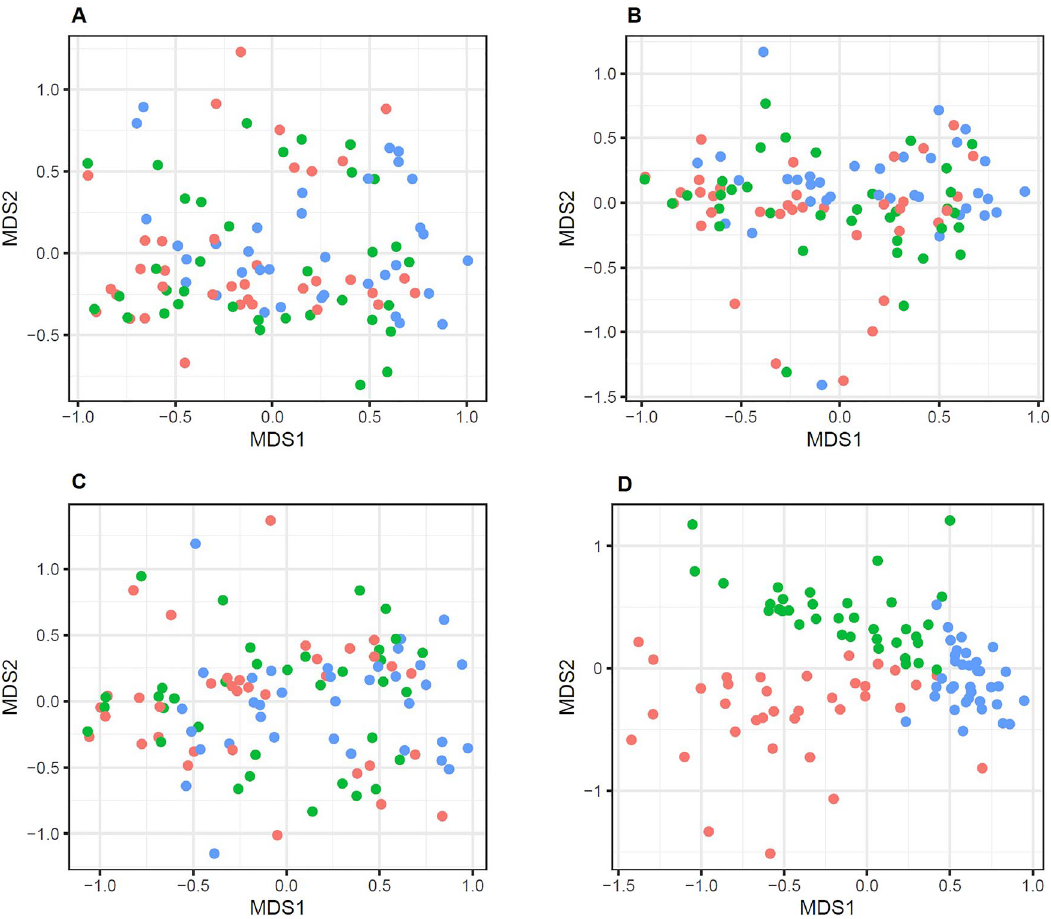
Figure 3. Bacterial community structures of urine depending on the way of sampling (red, first-catch urine; green, mid-stream urine; blue, catheterised urine), under 4 different filtering of OTUs ( A – D ). NMDS ordination plots showing the dispersion of samples by their dissimilarity (Bray–Curtis index) after removal of erroneus sequences: PERMANOVA p = 0.02, R 2 = 0.027 ( A ), after keeping only the top 3 OTUs per sample: PERMANOVA p = 0.01, R 2 = 0.039 ( B ), after keeping the 100 most abundant OTUs in the whole dataset: PERMANOVA p = 0.02, R 2 = 0.037 ( C ) and after filtering the most descriptive OTUs based on their prevalence using the PIME algorithm: PERMANOVA p = 0.01, R 2 = 0.348 ( D